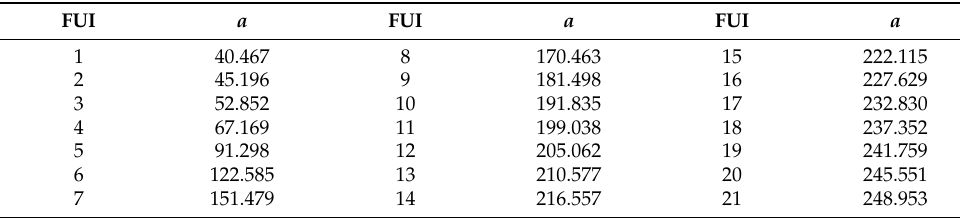
Table A2. The FUI look-up table under the second hue definition